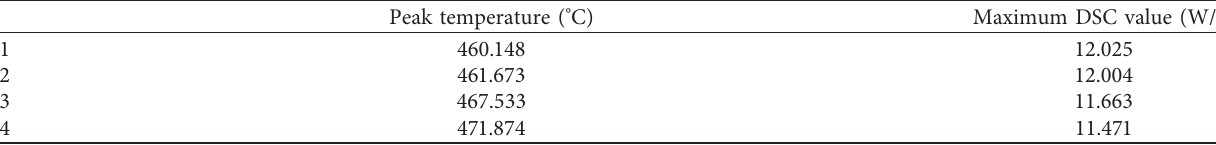
Table 2: Peak temperature and maximum DSC value under experimental conditions 1–4 (Table 1).